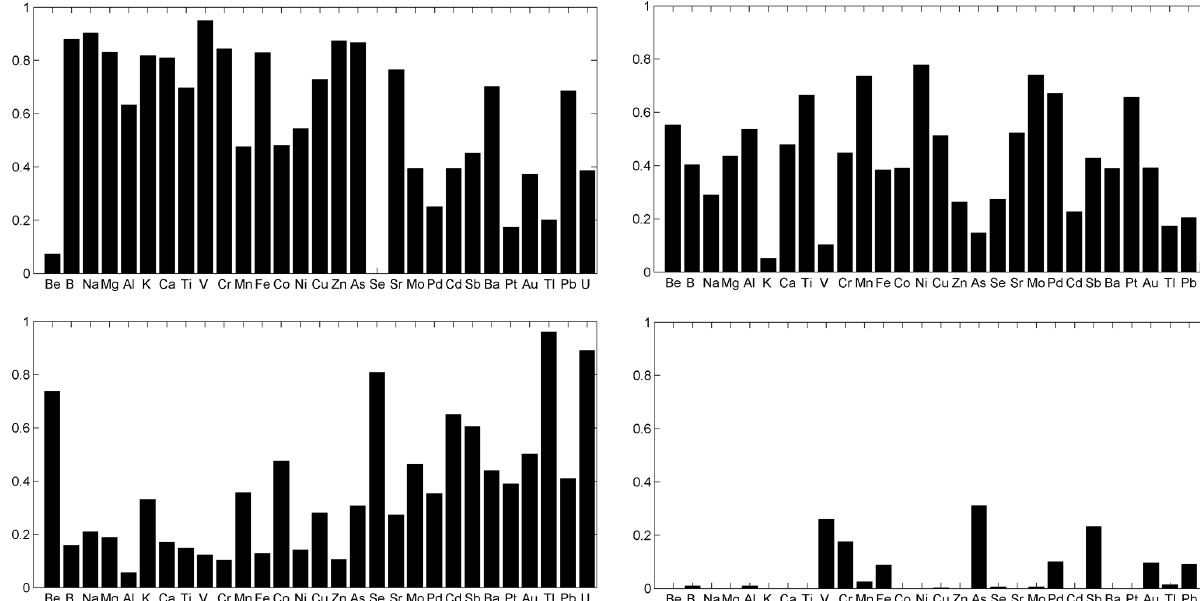
Figure 6. PCFA of the trace metal concentration in the PM 1 size fraction. Four dominant factors are